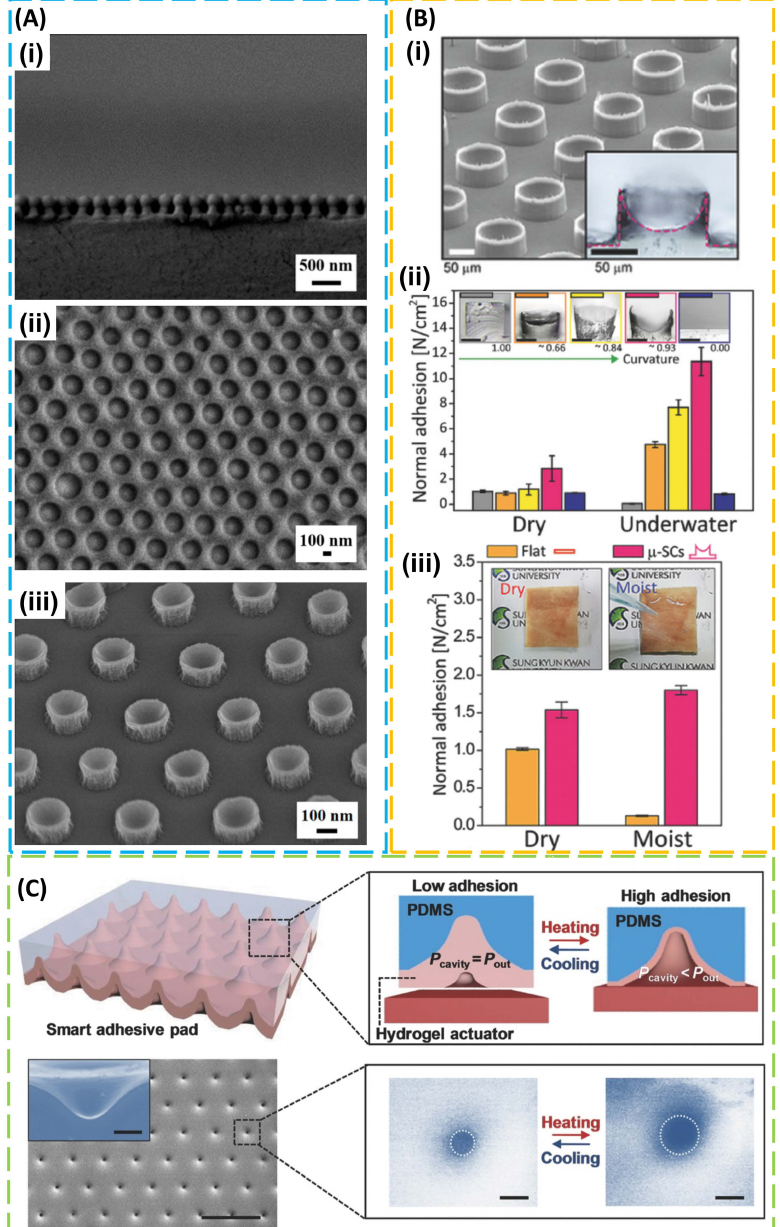
Figure 2. Octopus-inspired adhesive. ( A ) SEM images of ( i ) mushroom-like structures consisting of silica caps and polymer stems on a silicon wafer prepared by plasma etching; ( ii ) a polyvinyl alcohol (PVA) composite film embedding silica nanoparticles; ( iii ) a polydimethylsiloxane (PDMS) nano-sucker array obtained from the PVA composite mold. Reproduced with permission from Reference [84];